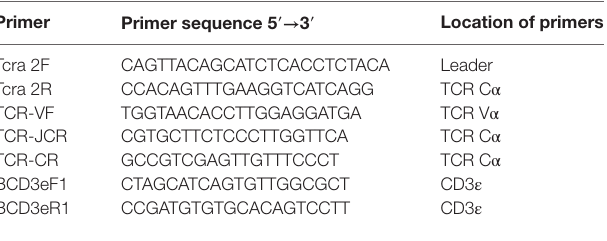
TaBle 1 | Primers used in this study.